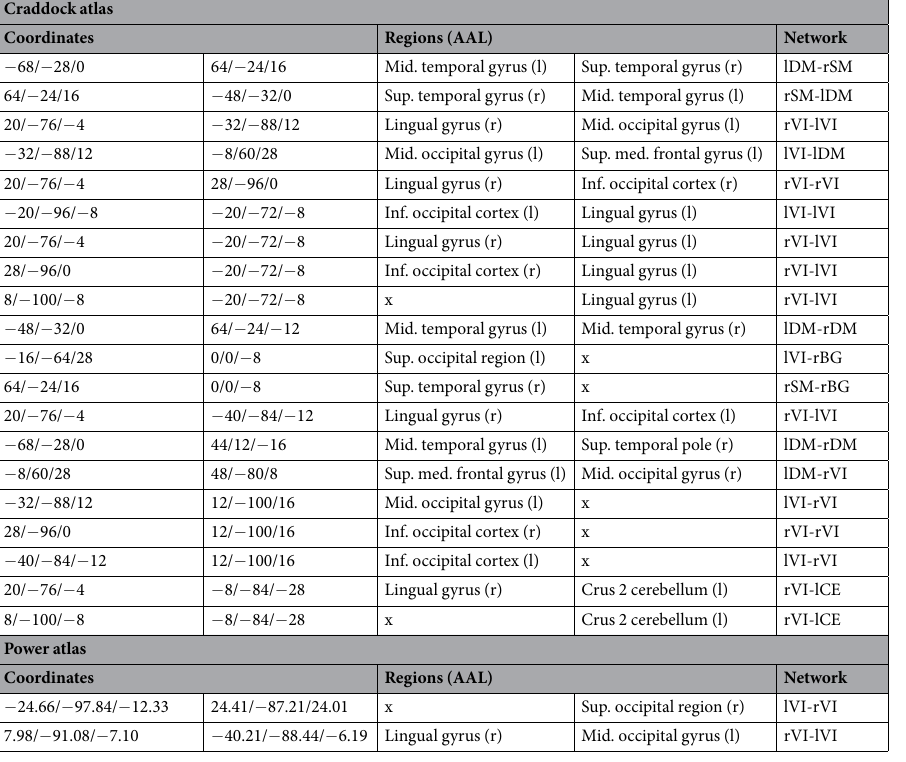
Table 2. Individual connections for which NBS revealed a negative influence of esketamine on dynamic rsFC across all methodological approaches. Illustrates individual region to region connections for which NBS 31 showed that esketamine had a significant negative influence on dynamic rsFC regardless of which methodological approach was used. Coordinates from the Craddock and Power atlases were translated to AAL and corresponding Yeo networks are noted to improve interpretability. AAL = Automated Anatomical Labeling atlas. x = coordinates from Craddock atlas 29 or Power atlas 30 , but not denoted in AAL. rVI/lVI: right/left visual network, * rSM/lSM: right/left somato-motor network, * rDM/lDM: right/left default mode network, * rBG/lBG: right/left basal ganglia, ** rCE/lCE: right/left cerebellum ** . * Networks based on Yeo et al . 32 , ** Regions based on Harvard-Oxford